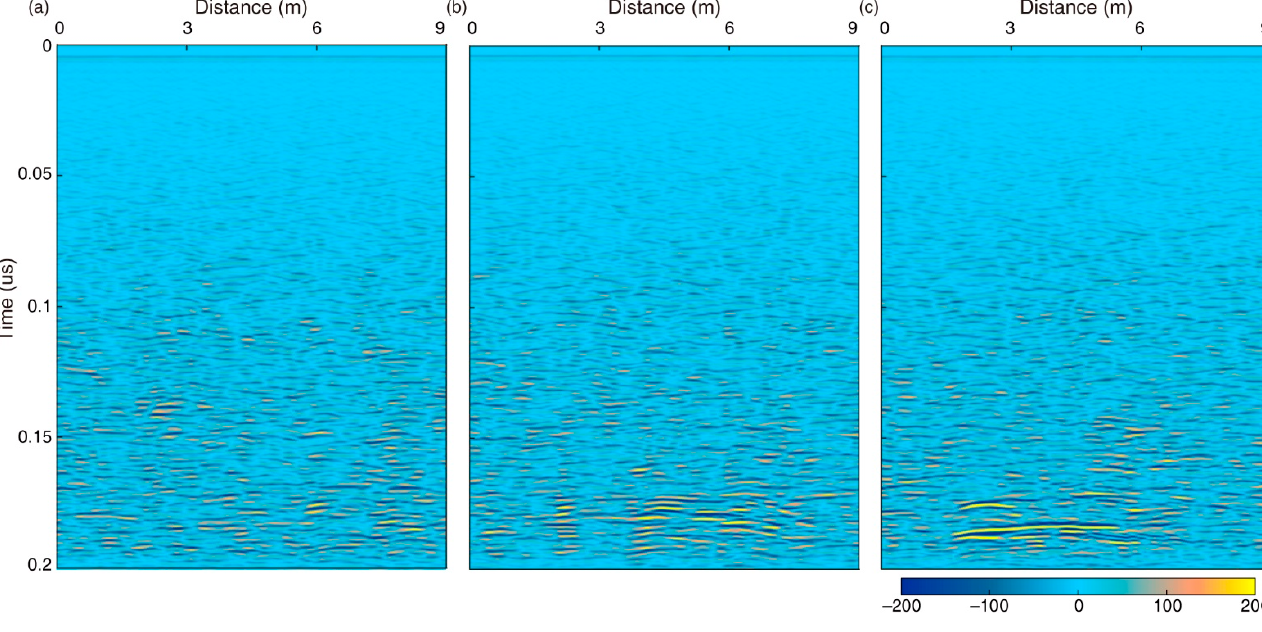
Figure 8. The simulated LPR profiles using the models shown in Figure 7. ( a ) Without rocky blocks; ( b ) with ~20 cm rocks; ( c ) with a ~1 m rock.